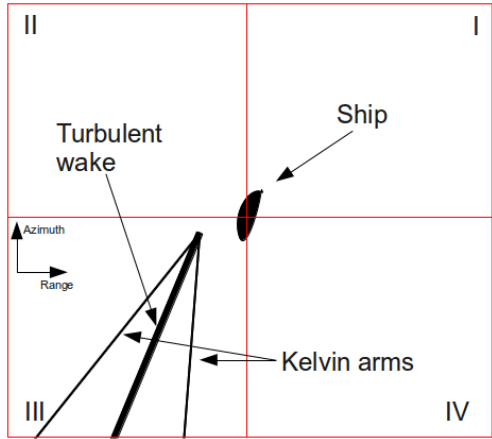
Figure 17. Example of a ship and its wakes with the grid for the resolution in ambiguity direction. The ship results displaced from its wake due to the relative motion between ship and platform. Roman numerals refer to the quadrant